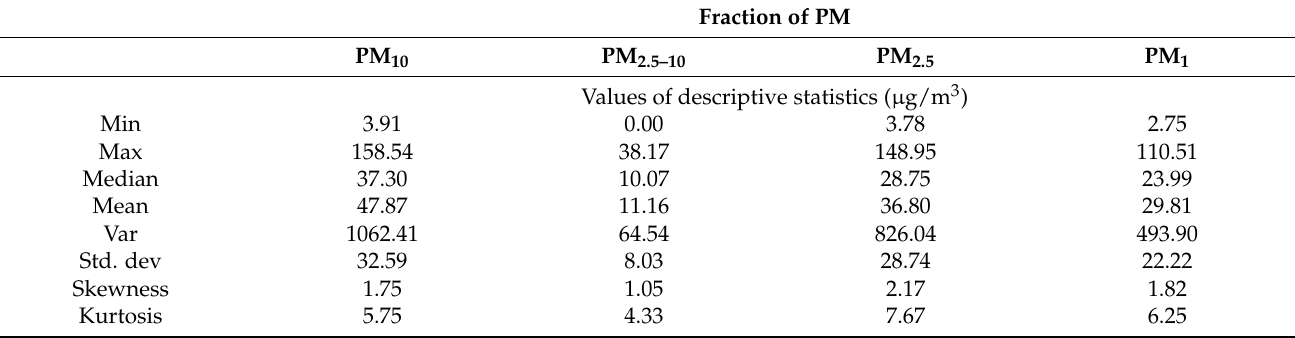
Table 3. Descriptive statistics of PM concentrations from measurements in the city of Žilina. Fraction of PM PM 10 PM 2.5–10 PM 2.5 PM 1 Values of descriptive statistics ( µ g/m 3 )